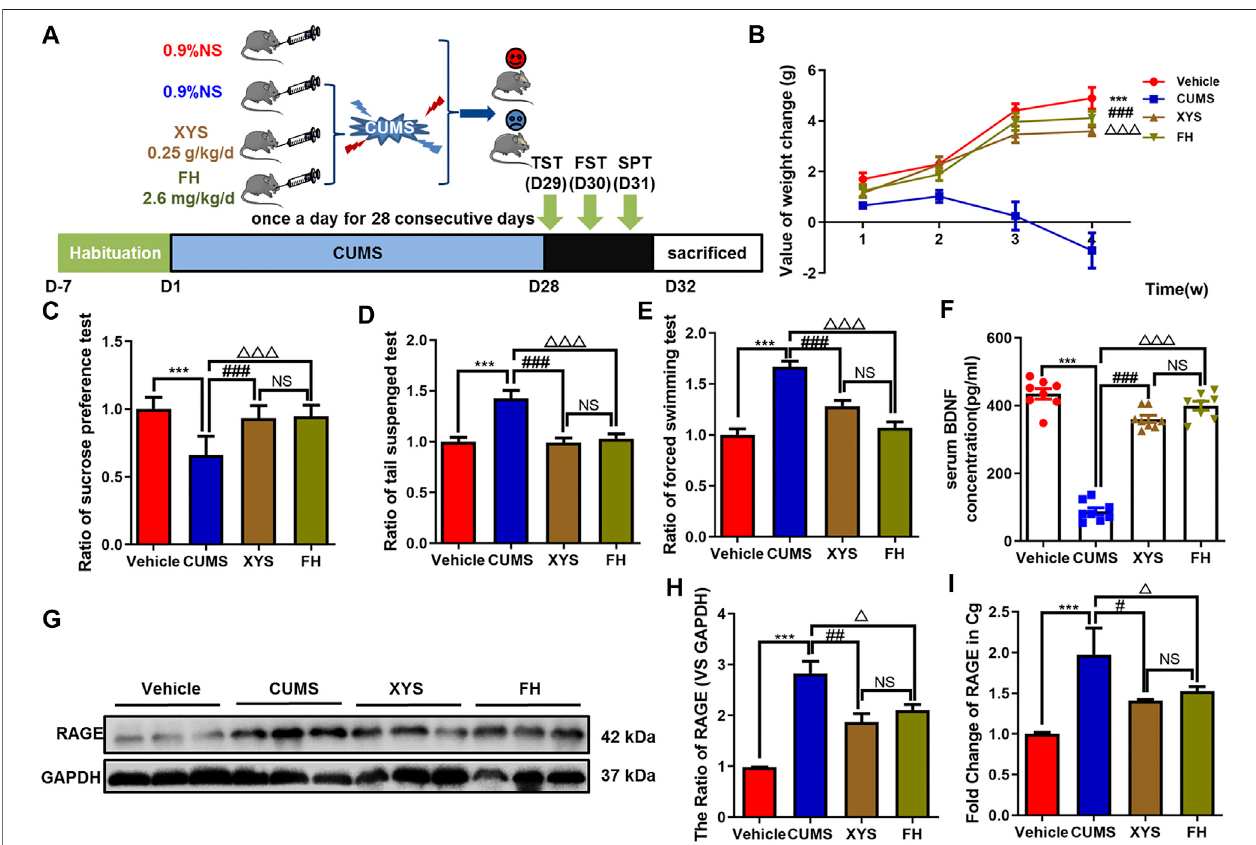
FIGURE5| Effect ofXiaoyaosanon behaviorand theexpression ofRAGE indepressive-likemice. (A) Schematicoverviewofexperimental approachand time line. (B) Thevalueofbodyweightchangesinmice. (C – E) Micebehavioraltests. (C) Sucrosepreferencetest(SPT); (D) tailsuspensiontest(TST);and (E) forceswimmingtest (FST). (F) TheexpressionofBDNFinserumofmice. (G – H) Westernblotandsemi-quantitativeresultsofRAGEinCgofmice. (I) ThemRNAfoldchangeofRAGEinCgof mice was detected by qPCR. One-way ANOVA followed by Bonferroni ’ s post hoc test; *** p < 0.001, CUMS group vs. Control group; # p < 0.05, ## p < 0.01 and ### p < 0.001, CUMS group vs. XYS group; △ p < 0.05, △△△ p < 0.001, CUMS group vs. FH group; error bars indicate mean ± SEM.